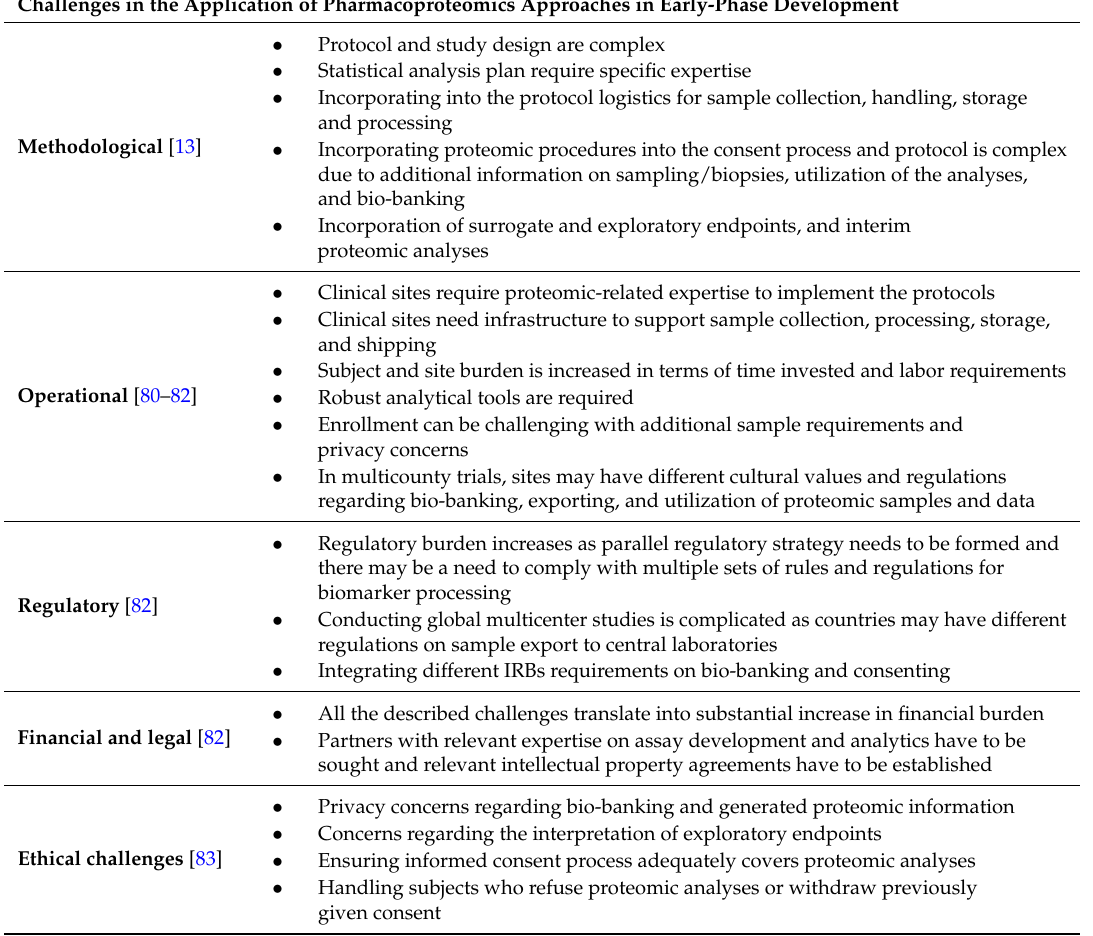
Table 3. Challenges of pharmacoproteomics applications in early-phase drug